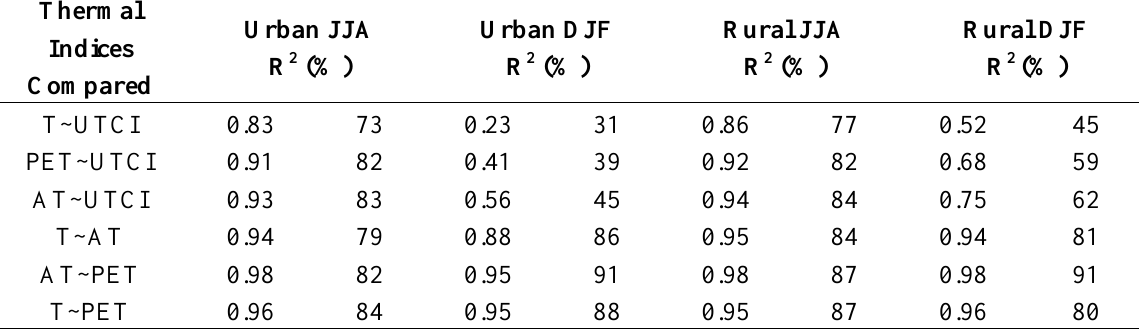
Table 3. Coefficients of determination (R 2 ) for linear relationships between mean daily UTCI, PET, AT, and T in the urban vs . rural region in summer (JJA) and winter (DJF) seasons. (%) denotes percentages of warm (cold) days in common in summer (winter) during